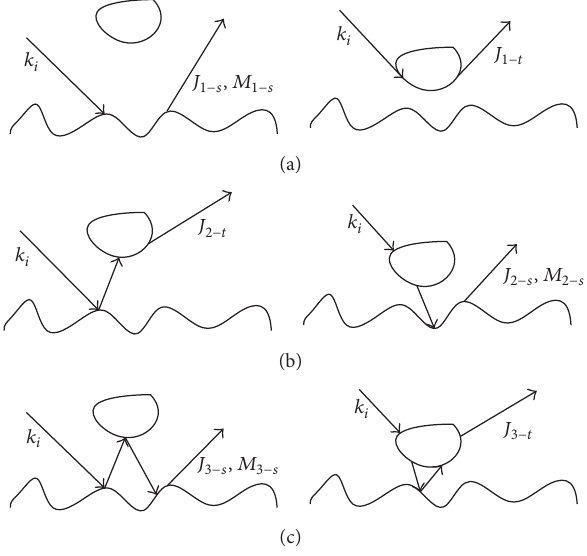
Figure 2: Multiple scattering